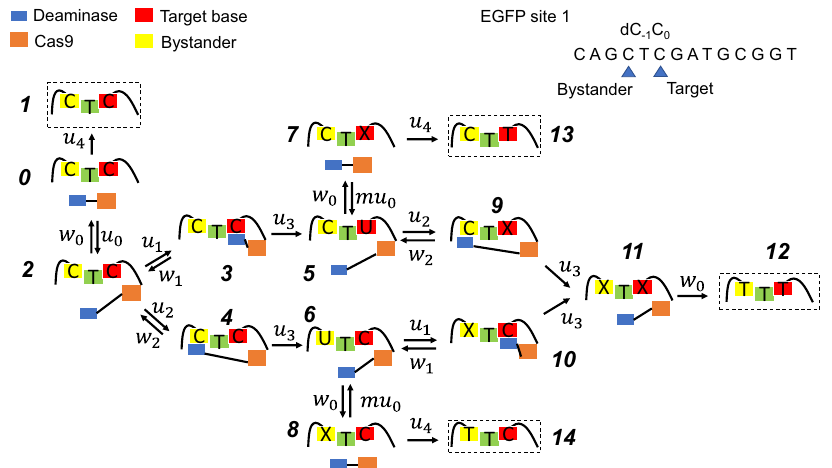
Fig. 1 Chemical-kinetic model of A3A-BE3 editing the EGFP site 1. Deaminase, Cas9, target and bystander base are represented by blue, orange, red and yellow squares, respectively. “ C ” represents cytosine, “ T ” represents thymine and “ X ” represents uridine or thymine. Editing is modeled as a multiple-step chemical reaction where Cas9 fi rst binds to ssDNA, cytidine then binds to the catalytic site of the deaminase and is chemically converted to thymidine. Here, u j and w j ( j = 0 – 4) represent the chemical-kinetic rates for various transitions. The model has a total of 15 states and can produce four outcomes (dashed squares): CTC (failed editing), CTT (only the target base is edited), TTC (only the bystander is edited), TTT (both target and bystander bases are